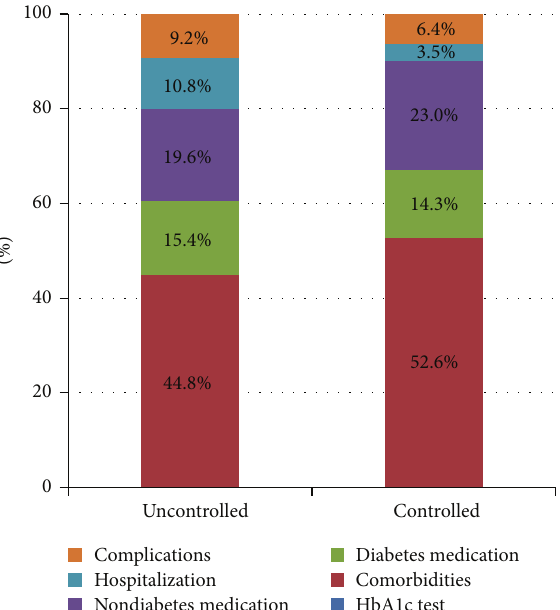
Figure1:Breakdownofthetotalcostofdiabetesmanagement.Note: cost of HbA1c test is 0.2% (C 13) of total cost; disability pensions are excluded.